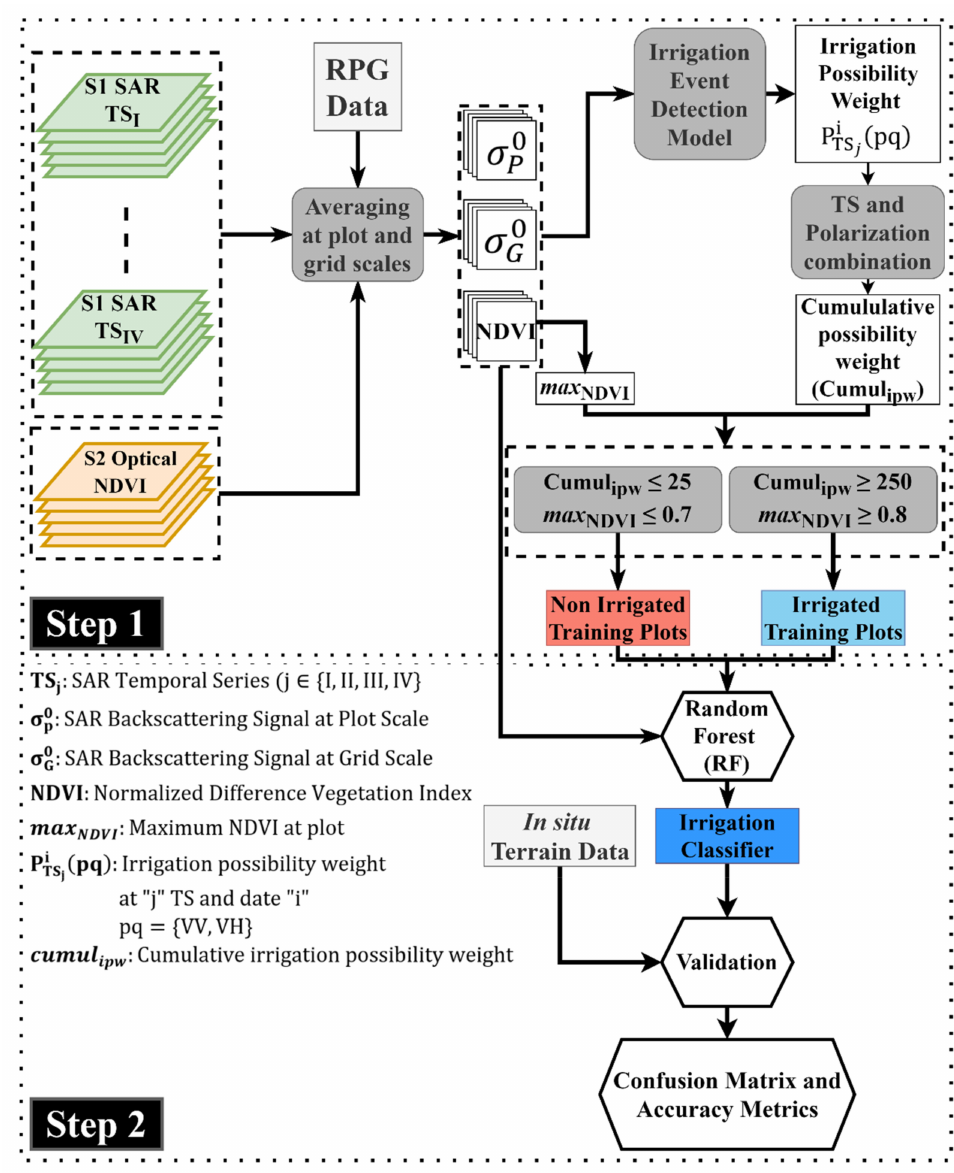
Figure 3. Overflow of the methodology for irrigation mapping at plot